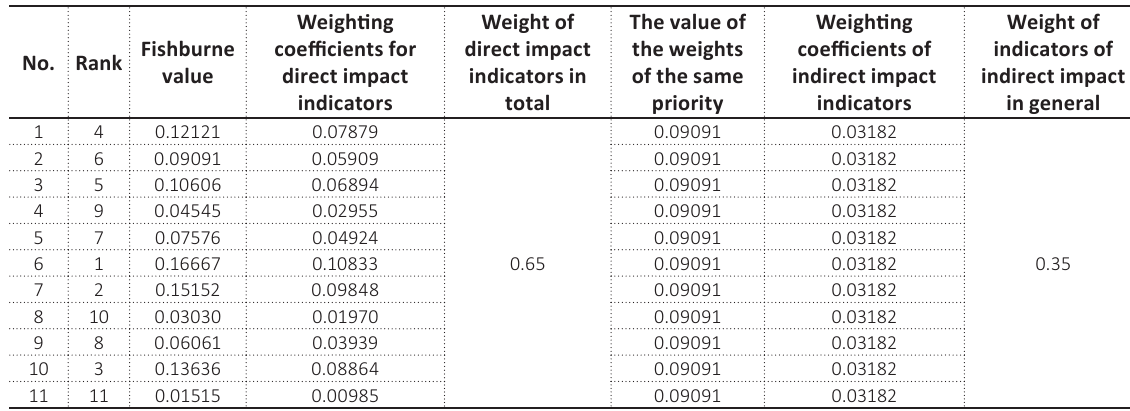
Table 4. Priority of financial security assessment indicators